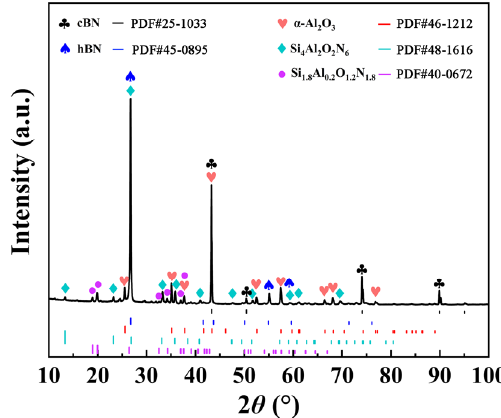
Fig. 2 XRD pattern of the as-sintered PcBN/hBN fibrous monolithic